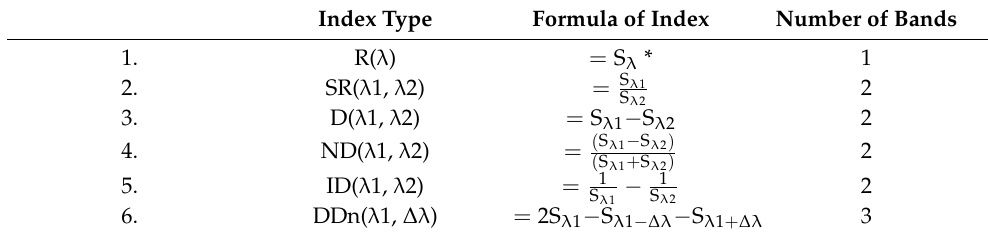
Table 1. The formula of different index types used in this study. Index Type Formula of Index Number of